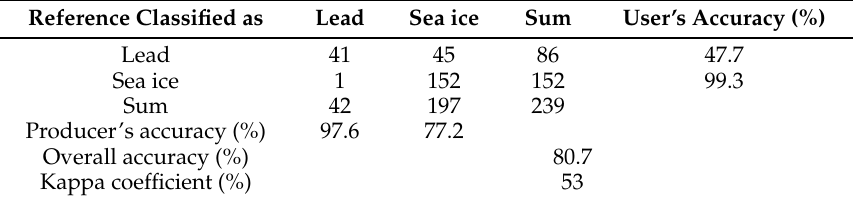
Table 10. The error matrix based on the lead detection results by the approach of Laxon et al. [18]. Reference Classified